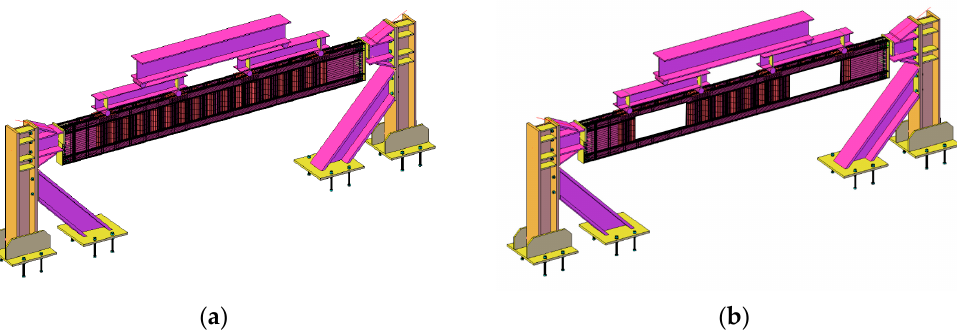
Figure 7. Built-up corrugated web girder: ( a ) without web openings; ( b ) with web openings. Based on obtained results for optimal shear connection and steel girder solution, the experimental tests of the composite LWT-FLOOR system are performed. Figure 8 shows the proposed test set-up for the LWT-FLOOR beam.